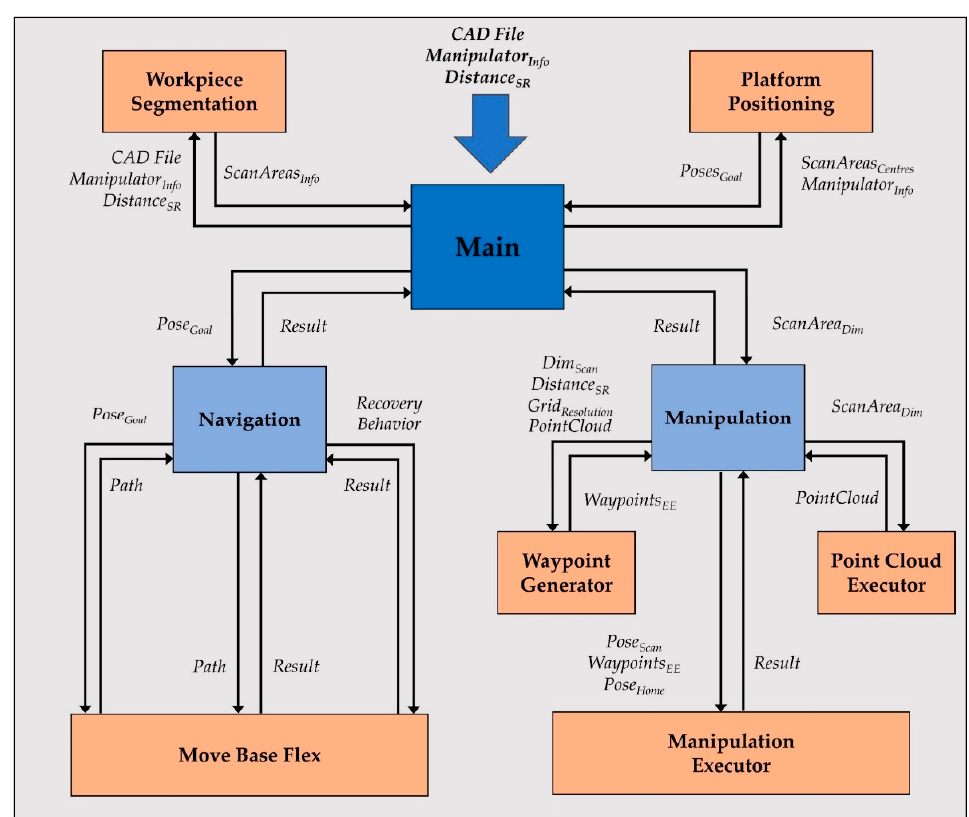
Figure 10. Task management system. State machines in blue and ROS nodes in orange.